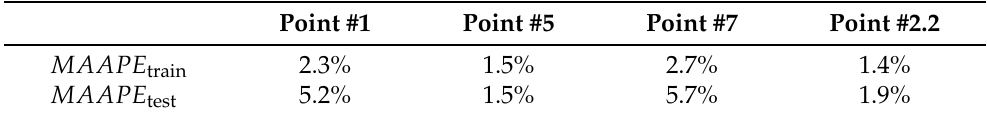
Table 4. MAAPE for t _ Ac 1 using sPGD model.